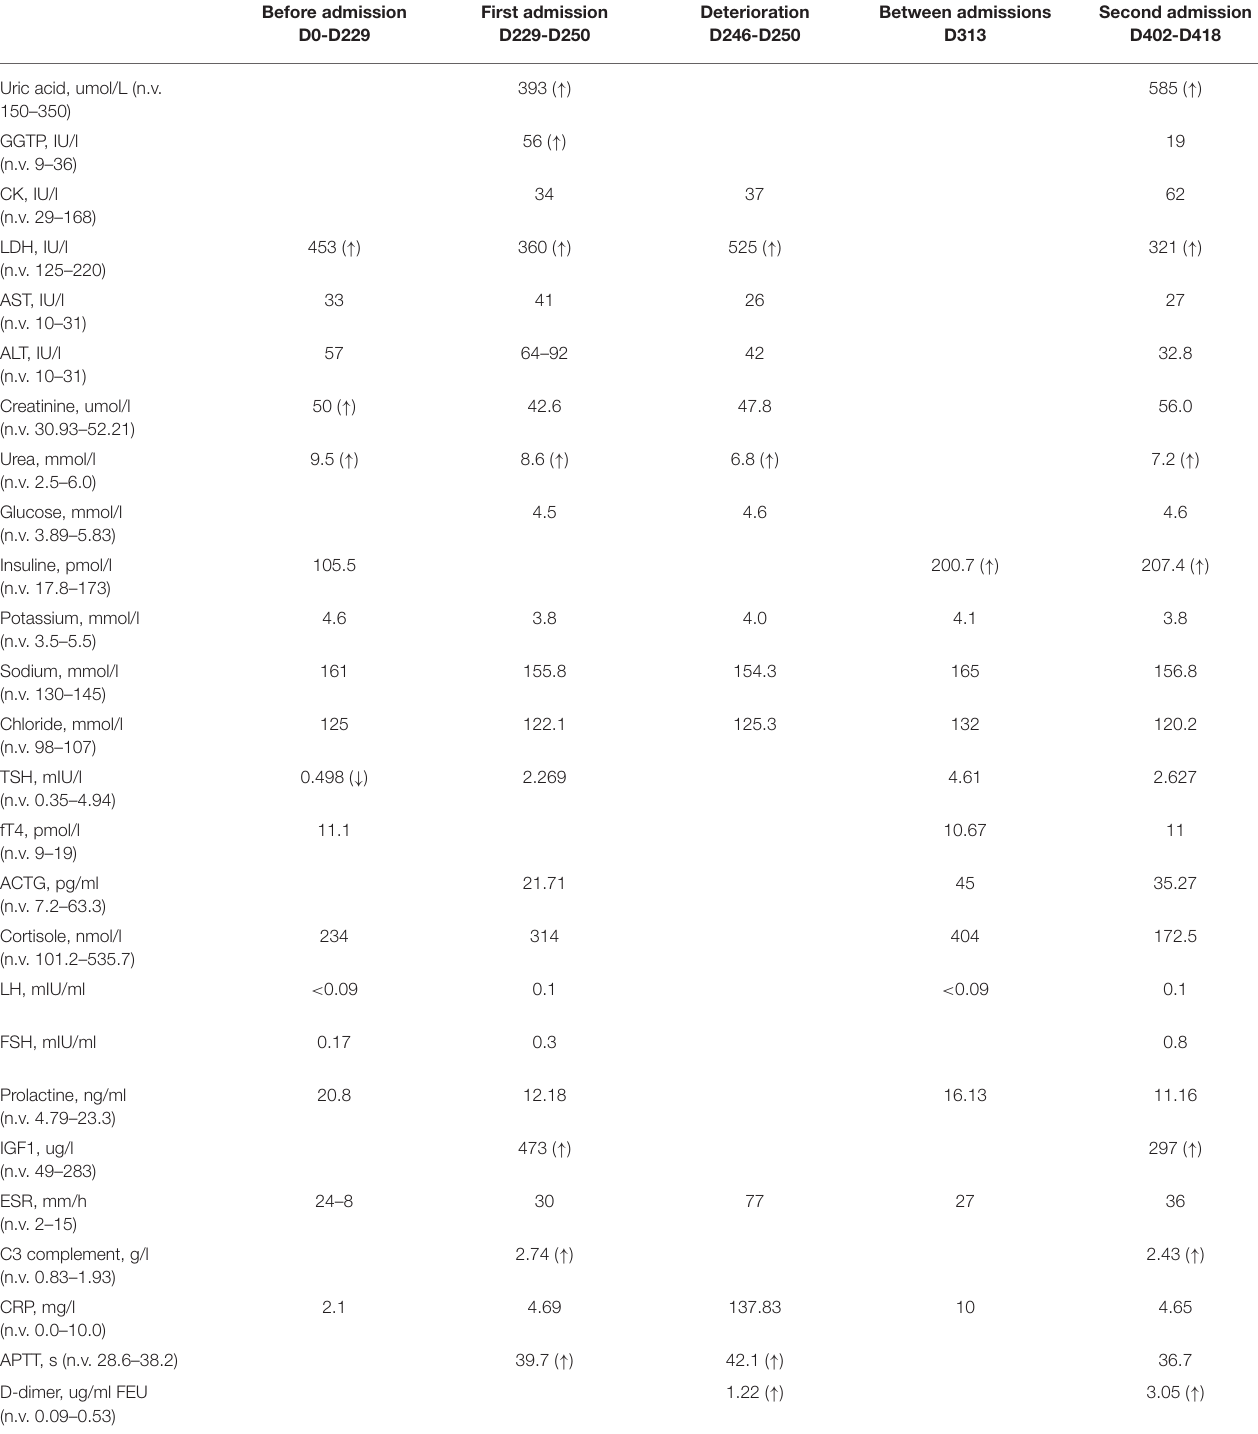
TABLE 1 | The laboratory feature dynamics during the disease